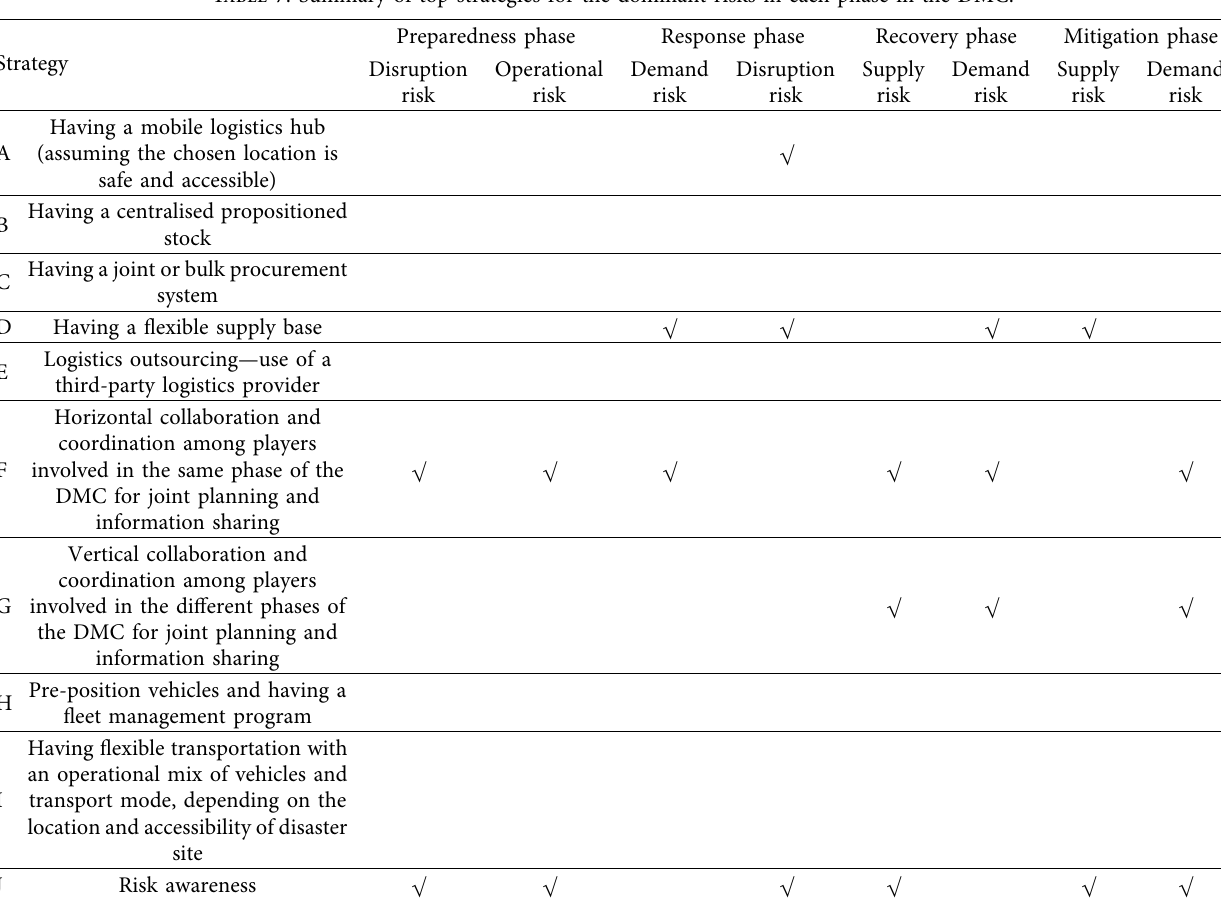
Table 7: Summary of top strategies for the dominant risks in each phase in the